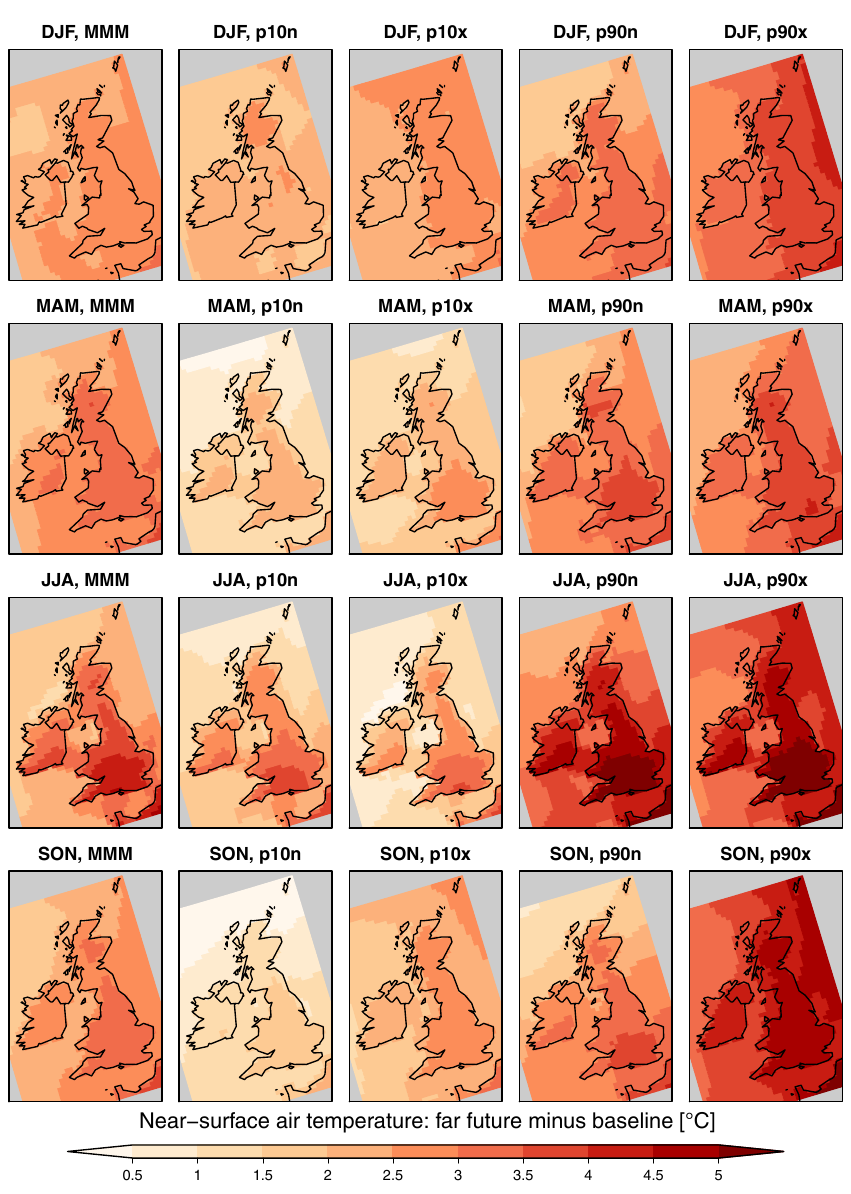
Figure 10. Difference in near-surface air temperature between far future and baseline (years 1975–2004 therein) for each season (row) and scenario (column). Hatching indicates grid cells with statistically non-significant changes at the 95% level according to a two-sided T test (almost all grid cells are significant here). The corresponding figure for the near-future time slices is shown in Fig.